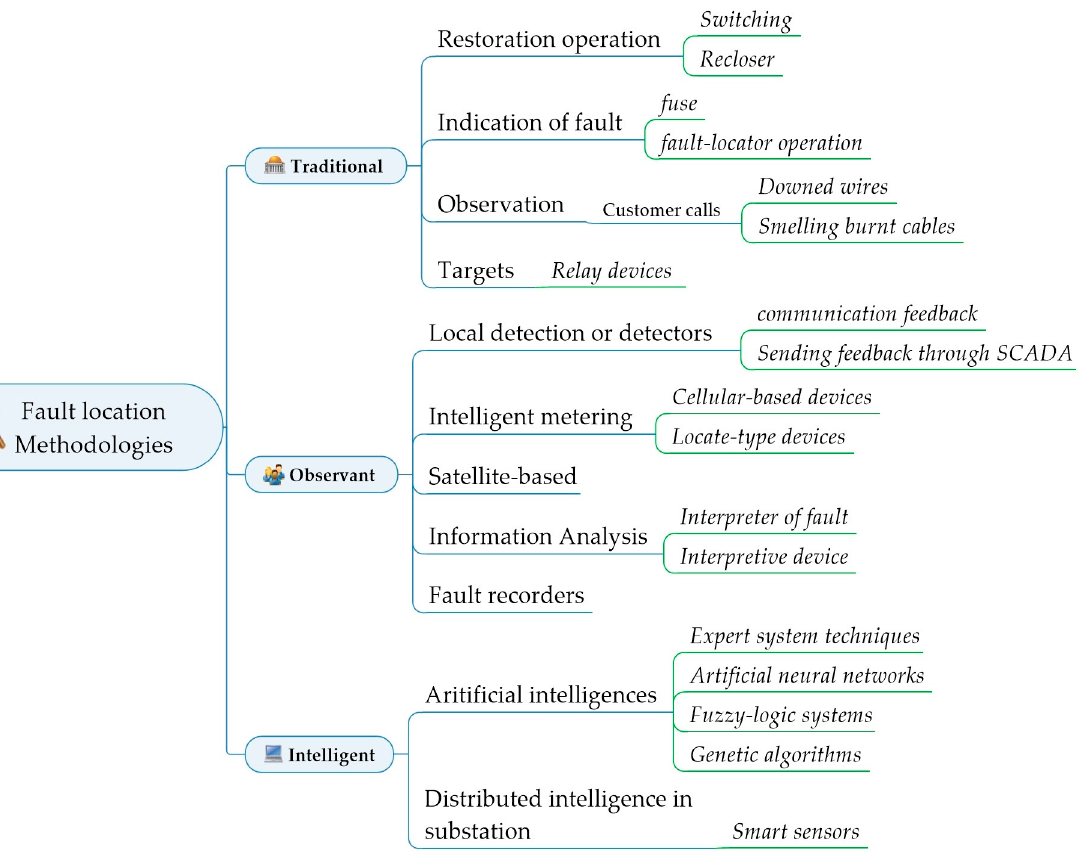
Figure 6. Fault location Methodologies for power systems [70].